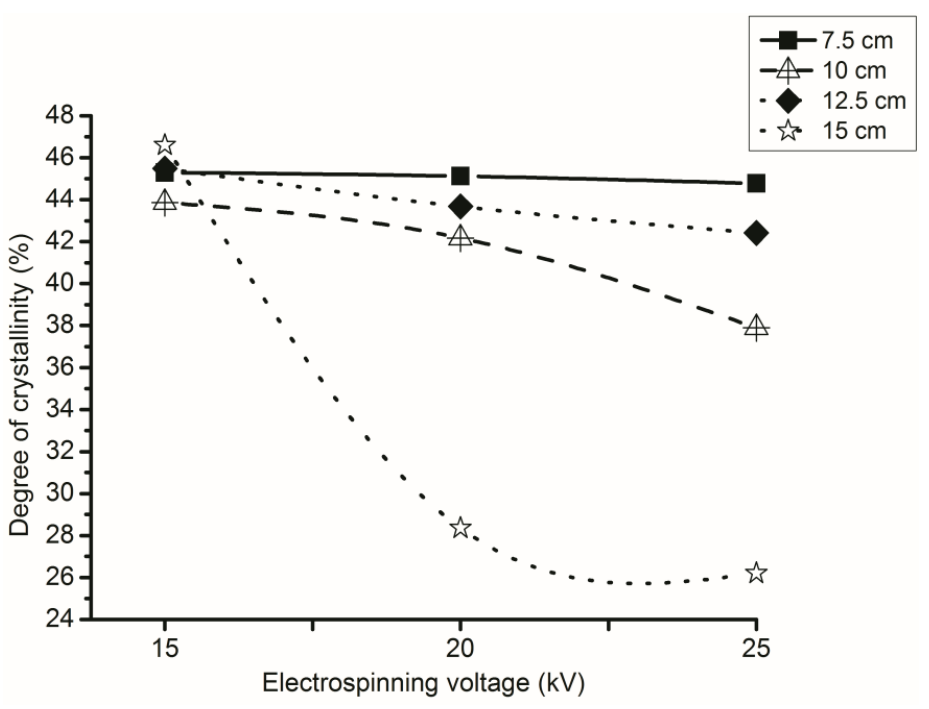
Figure 5. Effect of voltage on the degree of crystallinity of fibers electrospun from 5 wt% solution concentration at different